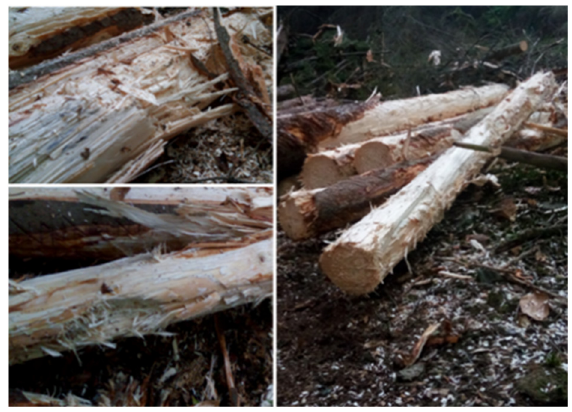
Figure 5. Damage to